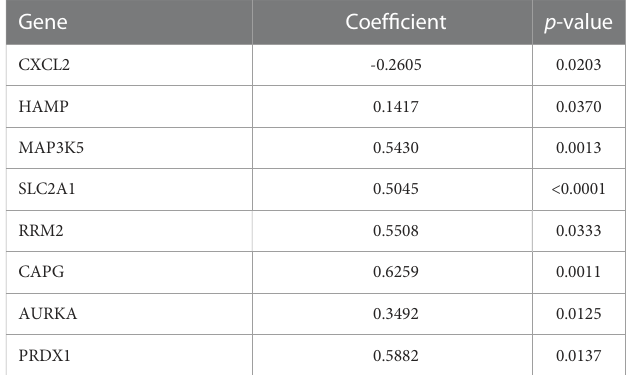
TABLE 1 Univariate Cox regression analysis of ferroptosis-related genes in GSE89749